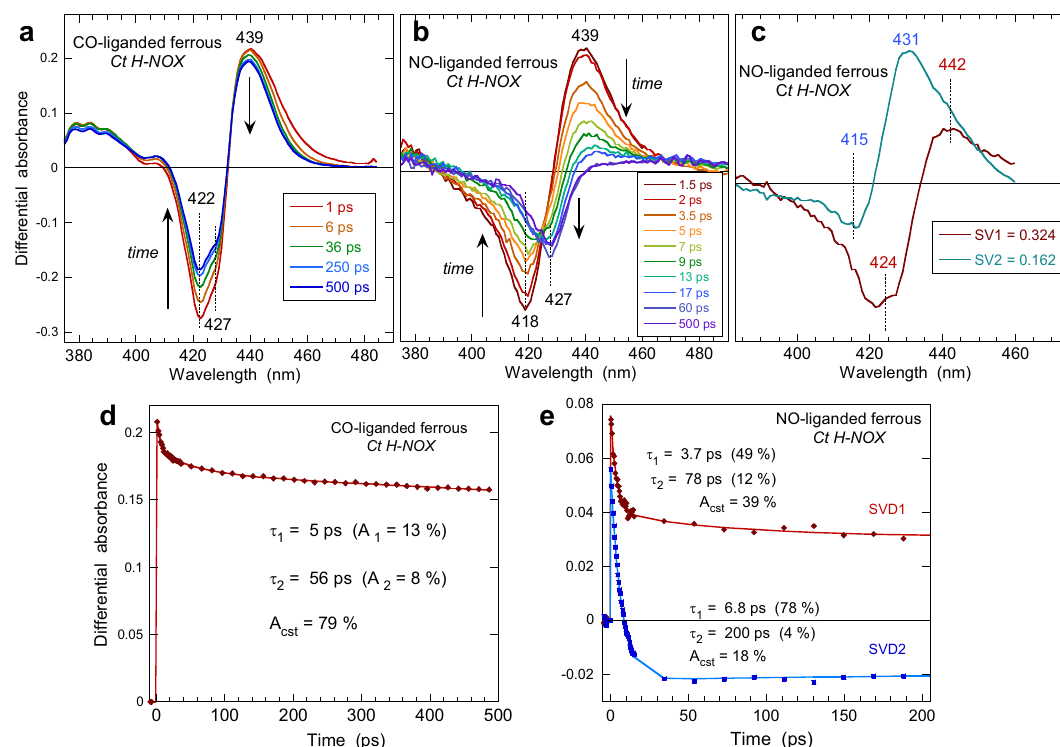
Fig. 5 Dynamics in CO-liganded and NO-liganded ferrous Ct H-NOX. Transient difference absorption spectra after the photodissociation of CO ( a ) and NO ( b ) from ferrous Ct H-NOX at increasing time delay ( λ ex = 564 nm). ( c ) Spectral components from Singular Value Decomposition analysis of the time- wavelength data matrix of Ct H-NOX – NO. Associated kinetic components together with time constants for CO ( d ) and NO ( e ). Kinetics were fi tted to the sum of two exponential terms with relative amplitudes A i and a constant term A cst (Supplementary Table